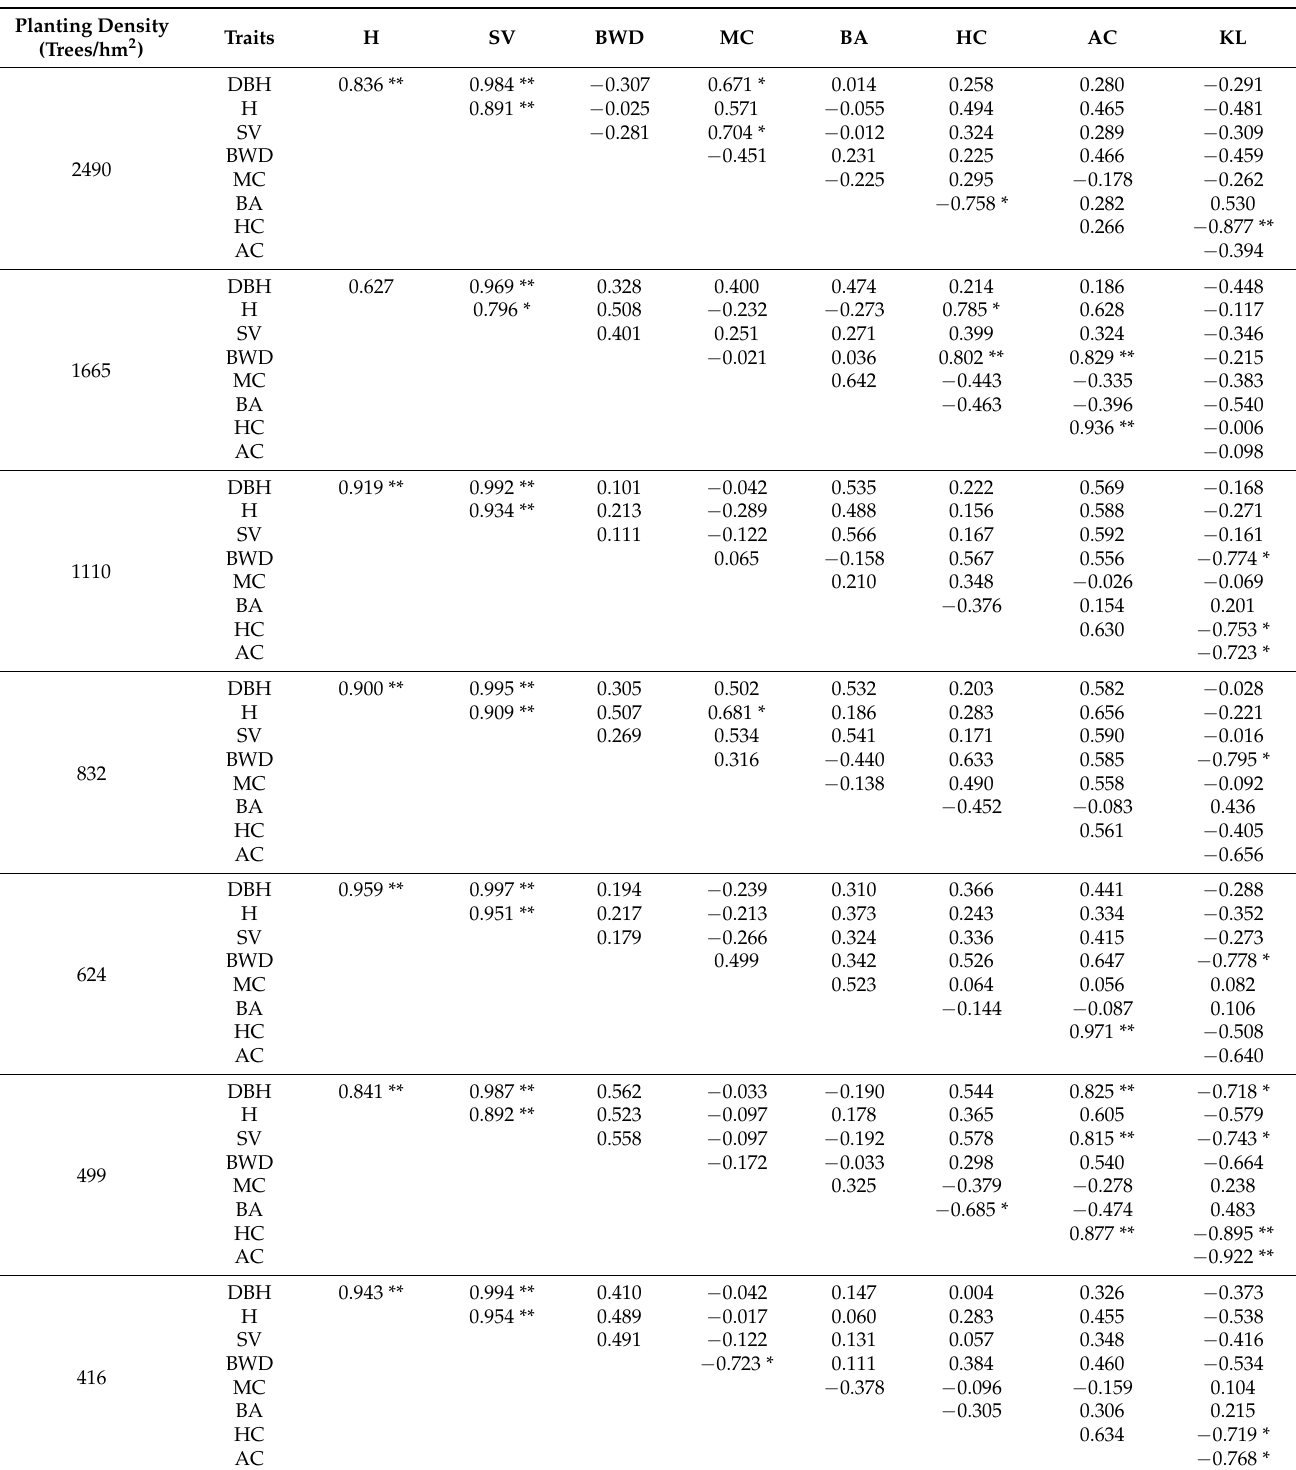
Table 5. Estimated phenotypic correlations between the growth traits, wood basic density, moisture con- tent, and four chemical components of the three triploid hybrid clones under the seven planting